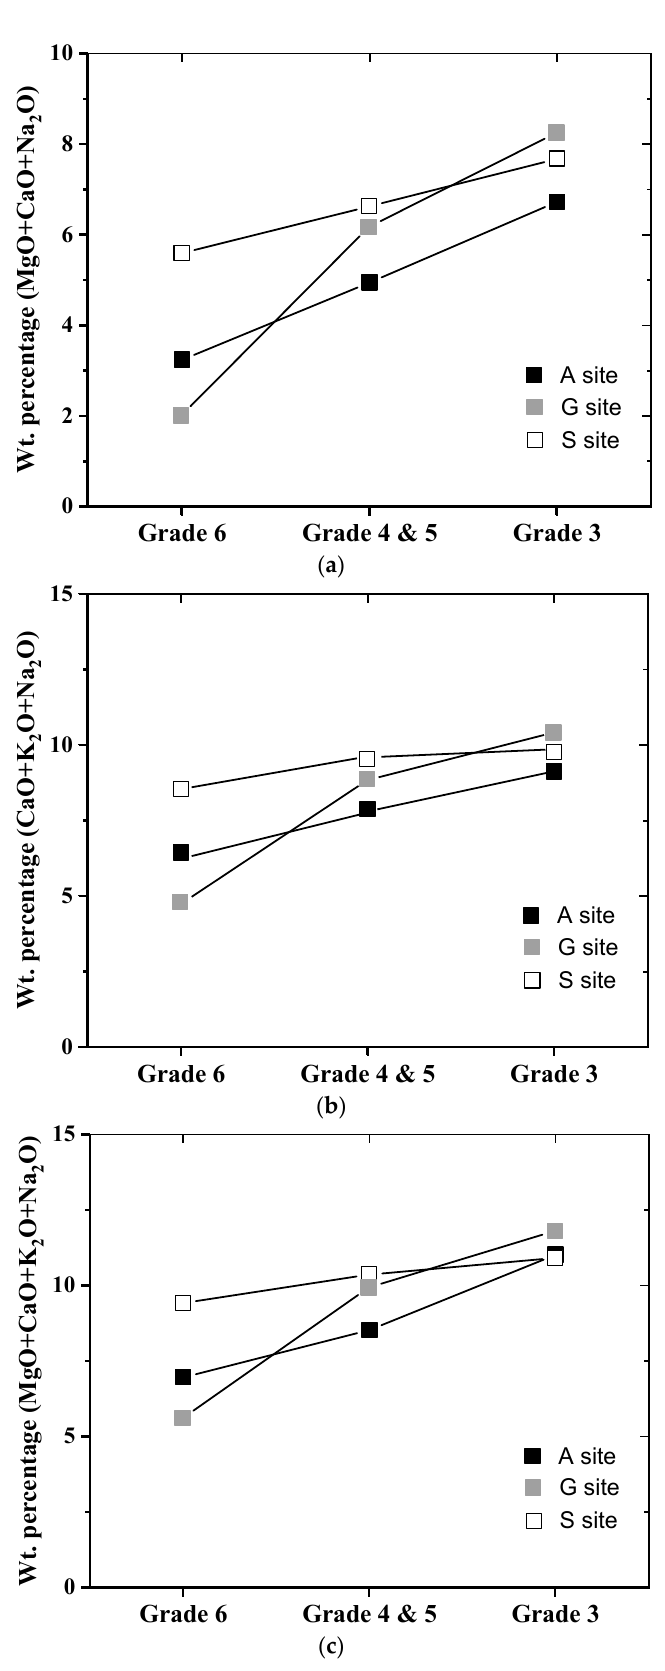
Figure 6. Weight percentage of the alkalis and alkaline oxides: ( a ) used in Vogt’s Ratio (VR); ( b ) used in Chemical Index of Alteration (CIA) and Mobiles Index (I mob ); ( c ) used in Modified Weathering Potential Index